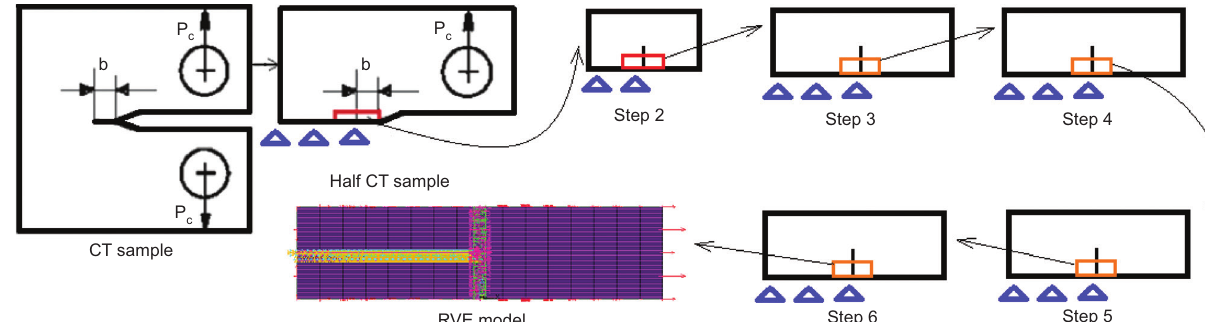
Figure 1 Fracture simulation of epoxy/SWCNT by global-local